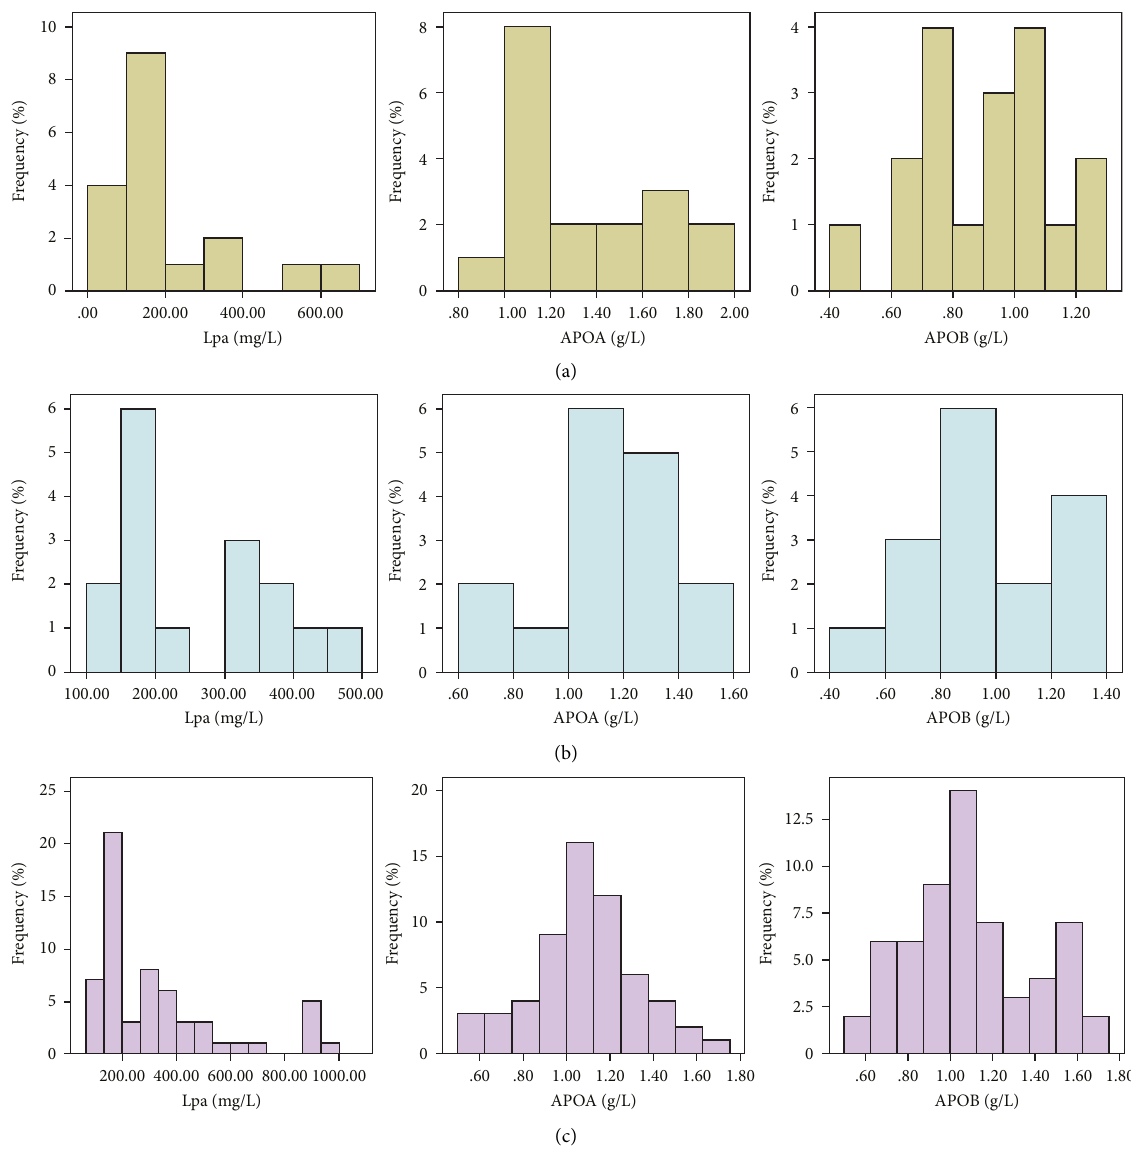
Figure 2: Distribution of Lpa, APO-A, and APO-B levels in CIS patients with diferent degrees of MCA stenosis. (a) Mild MCA stenosis. (b) Moderate MCA stenosis. (c) Severe MCA stenosis.